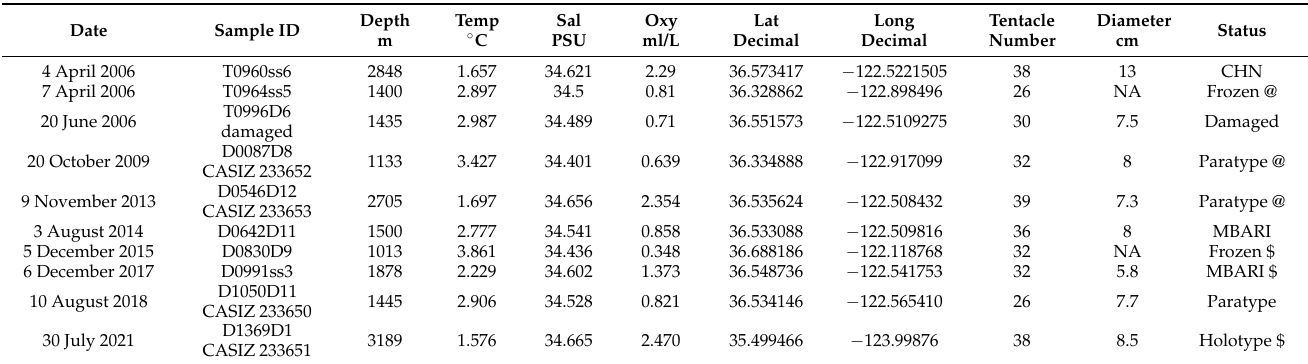
Table 2. Physical measurements and water parameters for the collected specimens of Atolla reynoldsi sp. nov.